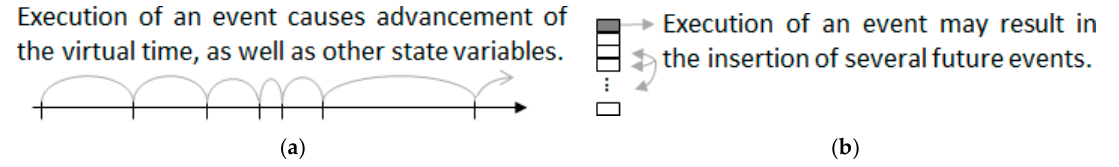
Figure 7. Fundamental components of a discrete event simulation (DES) framework, including ( a ) a virtual timeline that is subject to discrete steps and ( b ) a future event list.